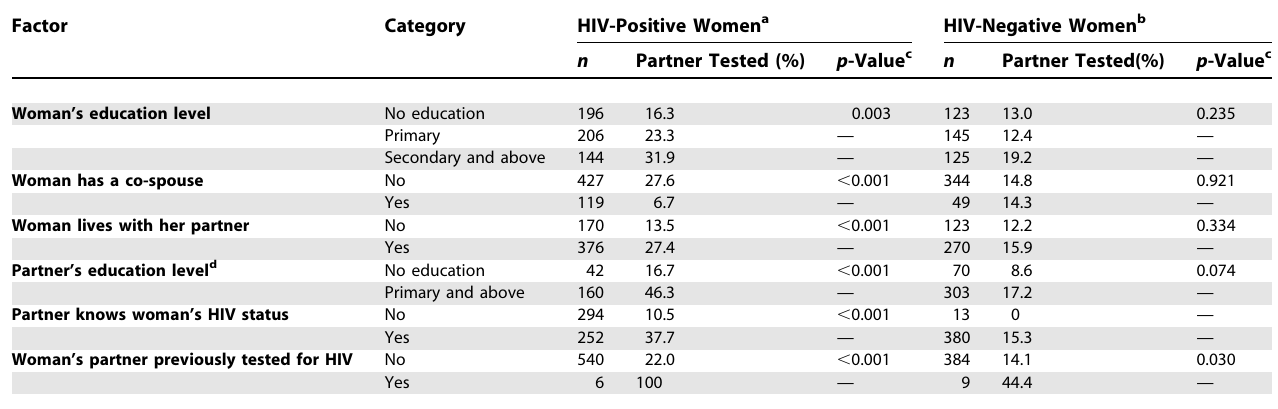
Table 3. Proportions of Male Partners Tested for HIV According to Women’s HIV Status (Ditrame Plus ANRS 1201-1202-1253, Abidjan, 2001–2005)